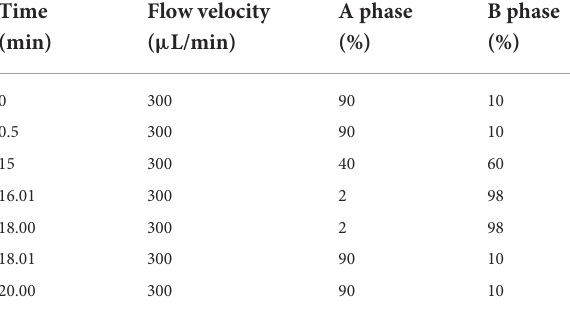
TABLE 1 Mobile phase conditions of liquid